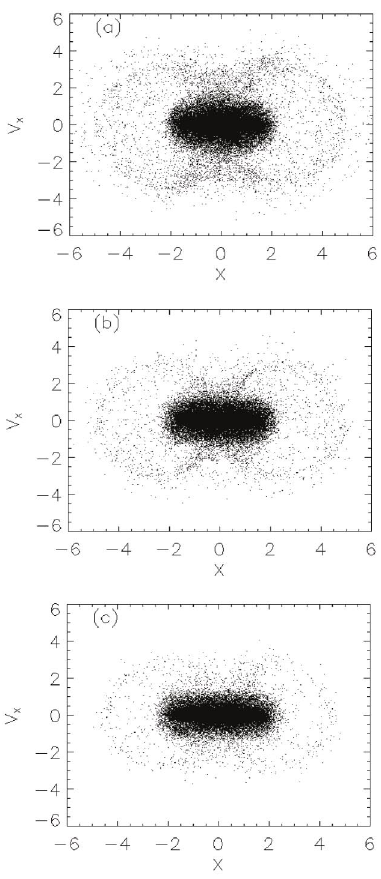
FIG. 4. Phase space distribution at last minimum rms width when S (cid:10) 300 for (cid:4) (cid:1) (cid:4) a (cid:5) 1.5, (b) 1.35, (c)